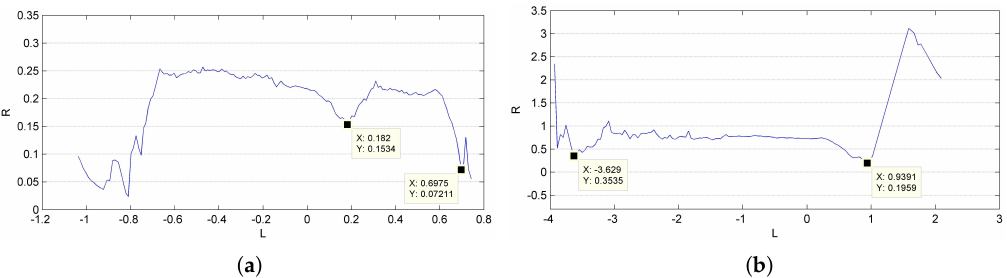
Figure 13. Outline of the reconstructed point cloud for ( a ) Shenzhou-6 and ( b )